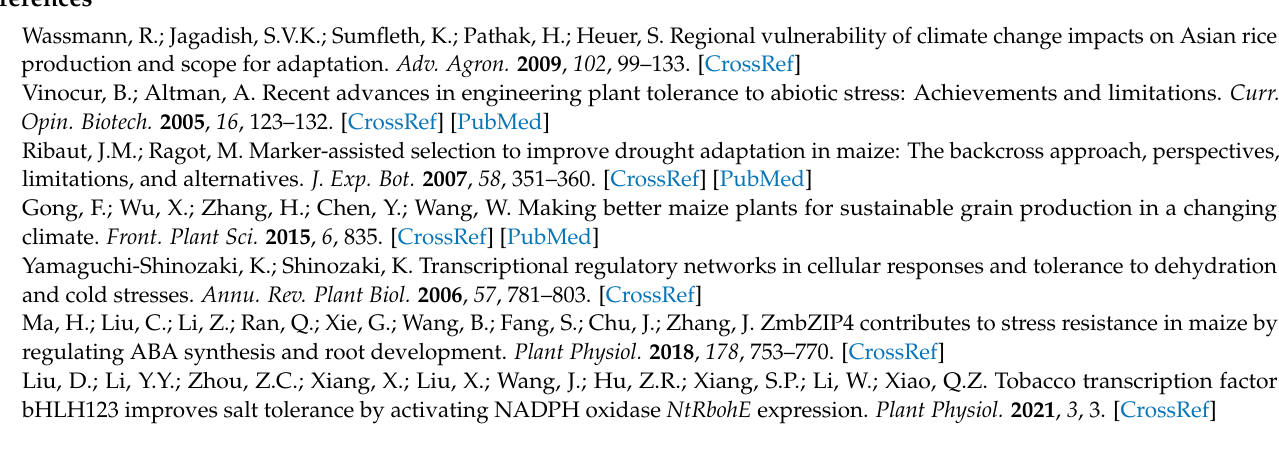
Figure S1: Enriched Gene Ontology (GO) terms among the common up-regulated DEGs in response to drought stress; Figure S2: Enriched Gene Ontology (GO) terms among the common down-regulated DEGs in response to drought stress; Figure S3: The principle component analysis (PCA) and the heatmap of correlation analysis among replicates in the same group and between different groups; Figure S4: The enrichment of DEGs in GO terms related to drought stress; Figure S5: Expression profiles of available ZmbHLHs in the present RNA-seq